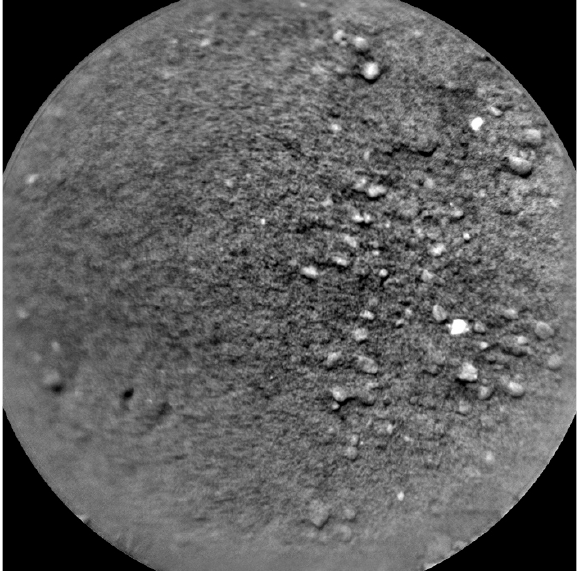
Figure 6 An example of one of the original ChemCam images in a stack of 16